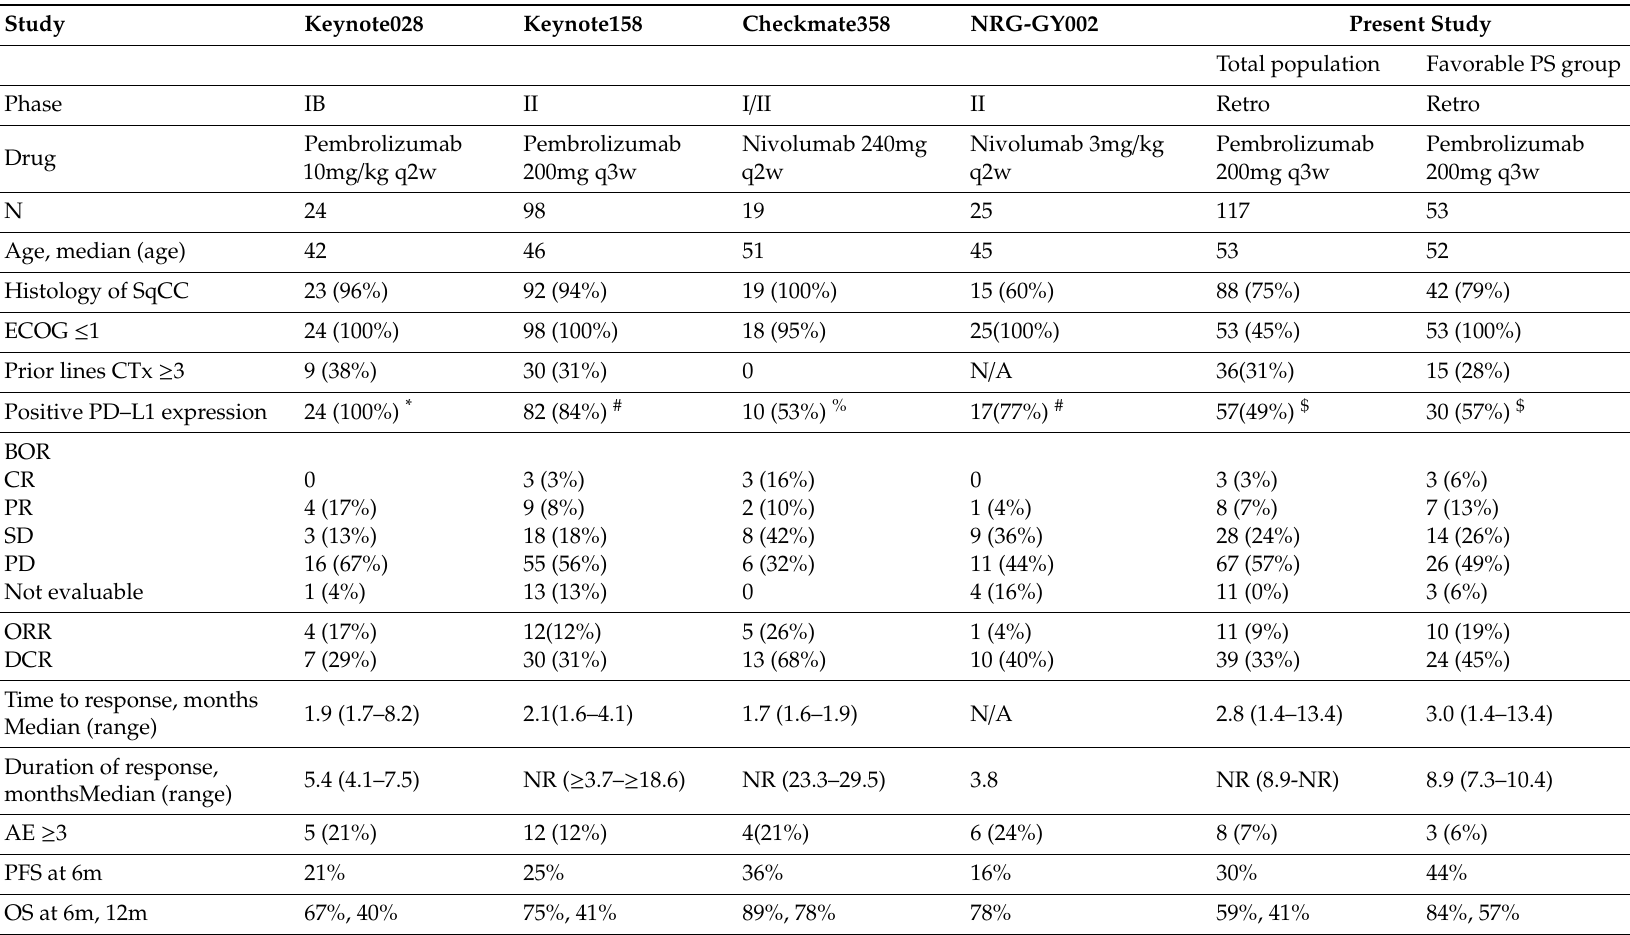
Table 5. Therapeutic results of PD-1 inhibitors monotherapy in recurrent or advanced cervical cancer